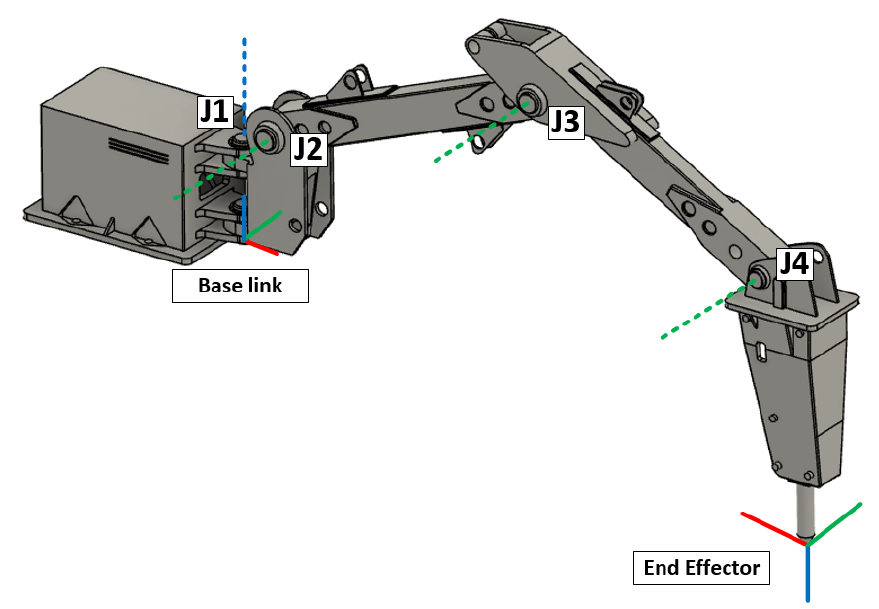
Figure 12. Simulated kinematic model of the impact hammer. J1, J2, J3, and J4 correspond to the hammer joints. The X -axis is shown in red, the Y -axis in green, and the Z -axis in blue.